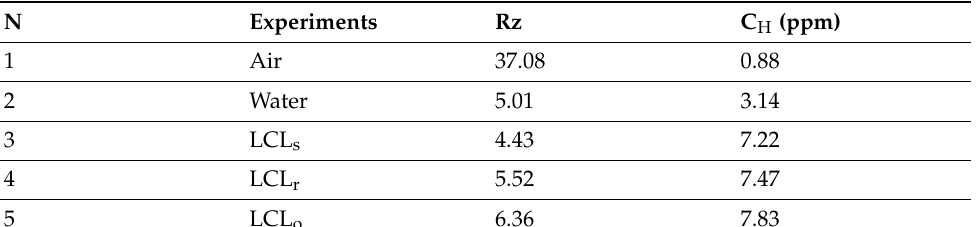
Table 3. Effects of cooling media on surface roughness of steel samples and hydrogen content in chips after turning.